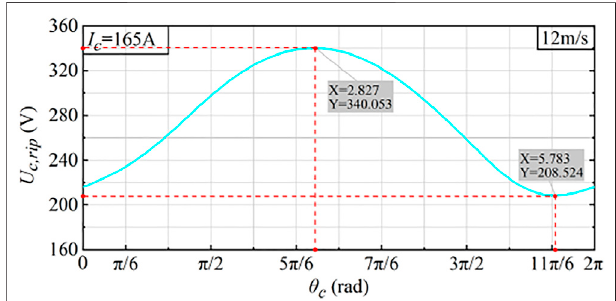
FIGURE 8 | Capacitor voltage ripple under different circulating current phase angles when v wind = 12